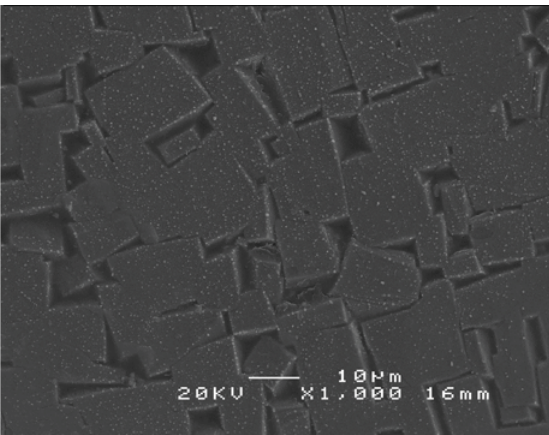
Figure 4. Scanning electron micrograph of the surface of NiO layer on Ni tape prepared at 800°C under reduced oxygen par- tial pressure.